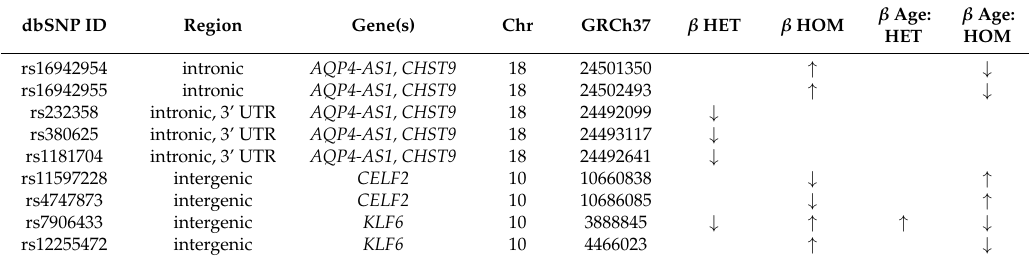
The arrows indicate either positive ( ↑ ) or negative ( ↓ ) estimates ( β ) of the SNP or SNP-age interaction on ΔSBP at p < 1 × 10 −4 .